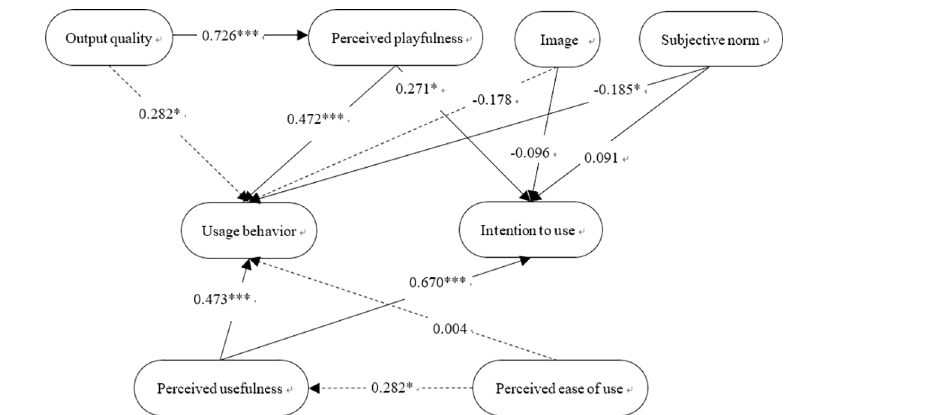
Fig 7. Path analysis model for research hypotheses pertaining to cognitive exergames.